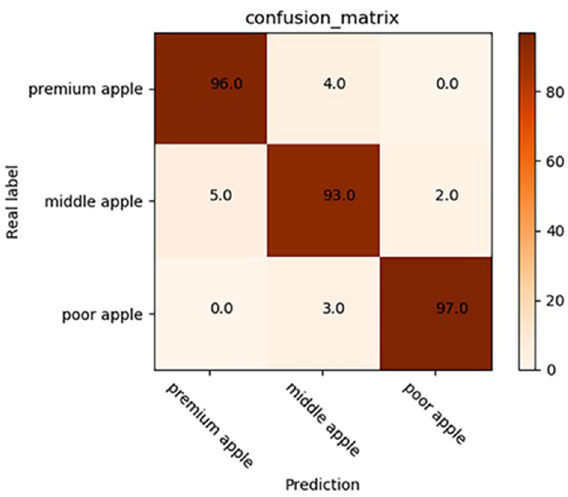
Figure 15. Confusion matrix of proposed model for the separate testing